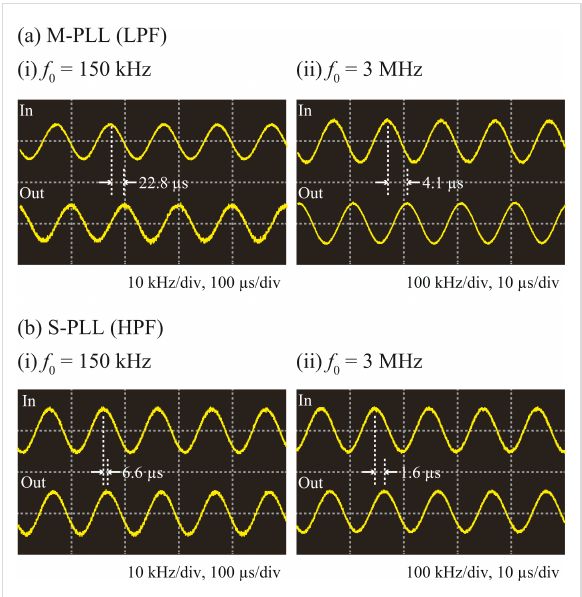
Figure 6: (a) M-PLL and (b) S-PLL waveforms at (i) f 0 = 150 kHz and (ii) f 0 = 3 MHz.